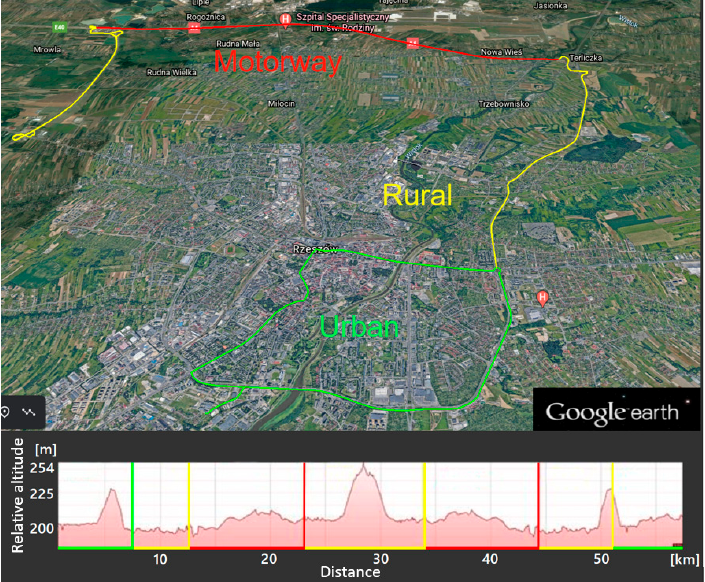
Figure 3. View of the test road with relative altitude graph.